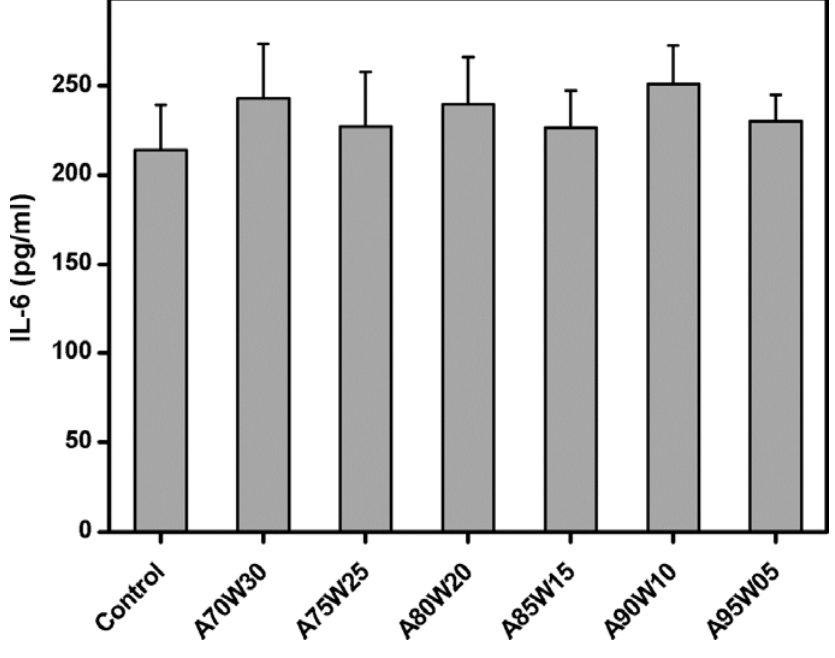
Figure 6. Level of IL-6 released from ARPE-19 cultures after exposure to various EDC cross-linked HA membranes for three days. The cultures in absence of HA materials served as control groups. Values are mean ± SD ( n = 4). No significant difference in the IL-6 level was observed between the control and all the experimental groups ( P >